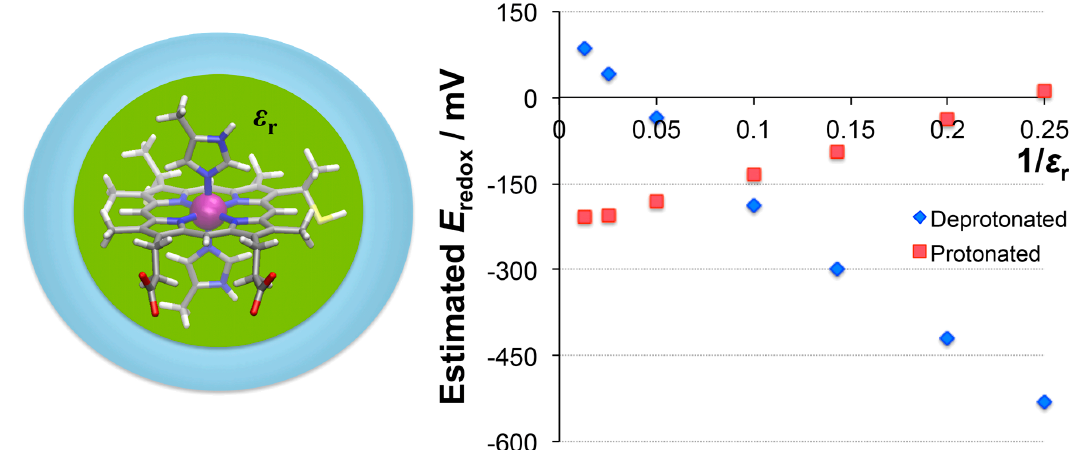
Figure 4. A plot of the redox potential against the inverse of ε r in heme c . In both states, the correlation is nearly linear.